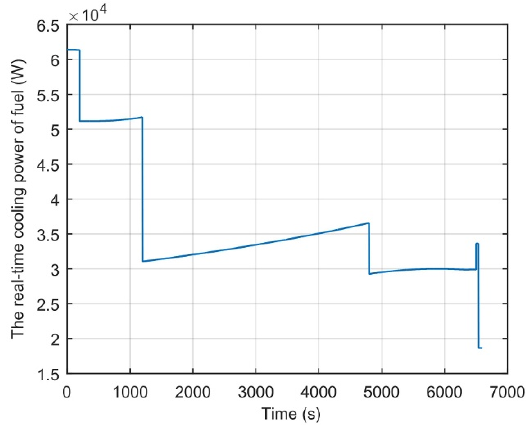
Figure 15. Real-time cooling power of fuel heat sink.